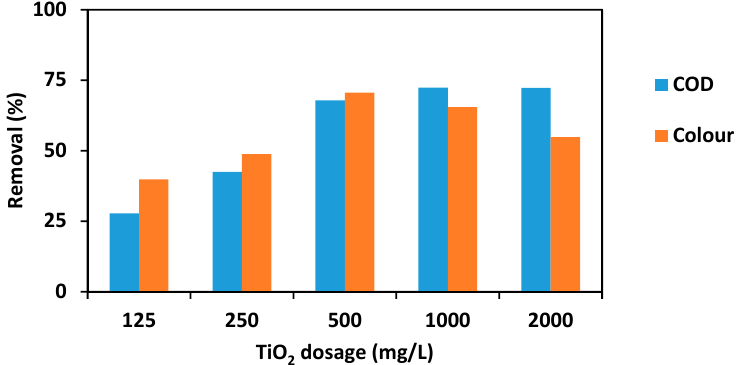
Figure 3. Effect of catalyst dosage on photocatalytic degradation (process conditions: pH—4, reaction time—3 h, UV light irradiation—64 W).